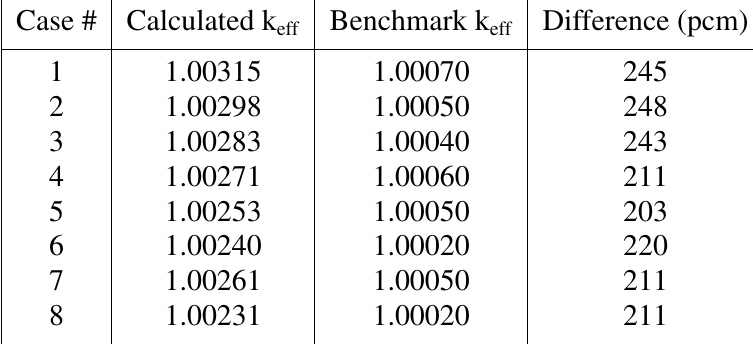
Table 4: LCT-054